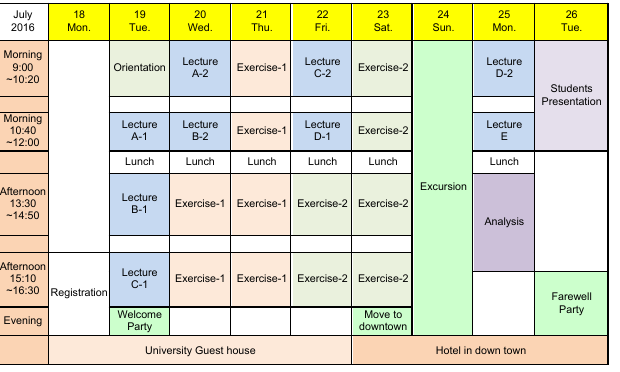
Fig. 4. Schedule of Ho Chi Minh city school in